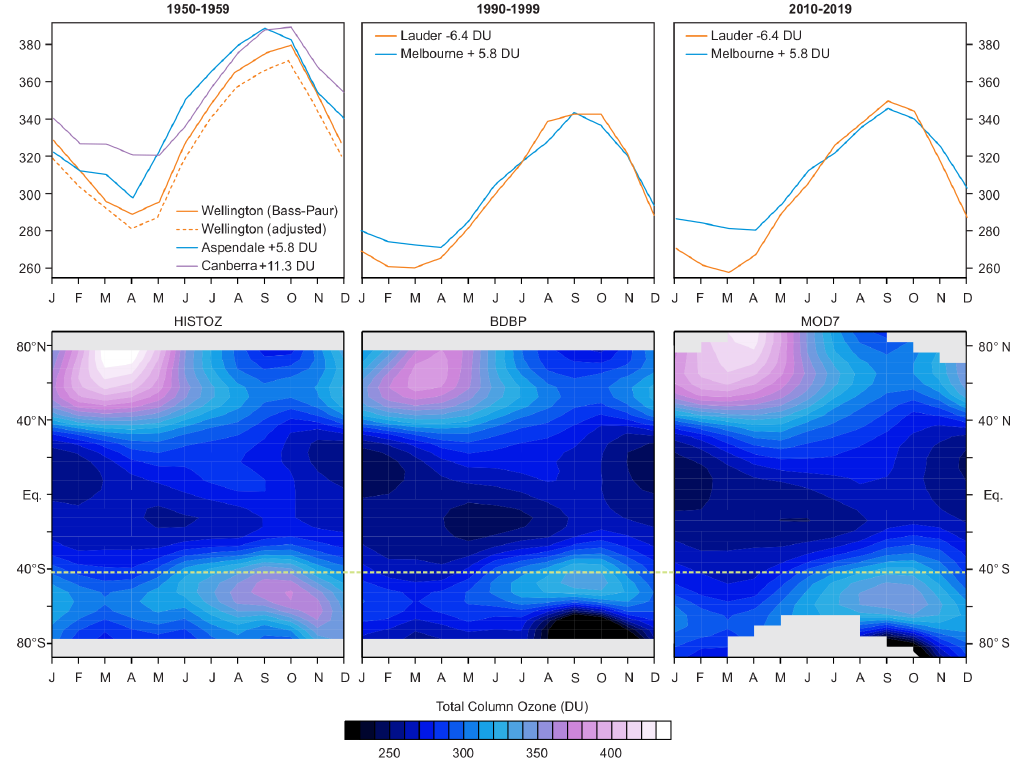
Figure 7. Top: decadally averaged annual cycle from total column ozone measurements in New Zealand and Australia in the 1950s, 1990s, and 2010s. Note that the series are adjusted according to the annual mean offset between the corresponding latitudes and that of Wellington in MOD7. Bottom: zonally averaged total column ozone as a function of calendar month and latitude in the data sets HISTOZ (1950s), BDBP (1990s), and MOD7 SBUV merge (2010s). The bottom left and middle panels are from Brönnimann (2015). Lauder and MOD7 data end in 2018. The dashed line indicates the latitude of Wellington. Grey: no data.